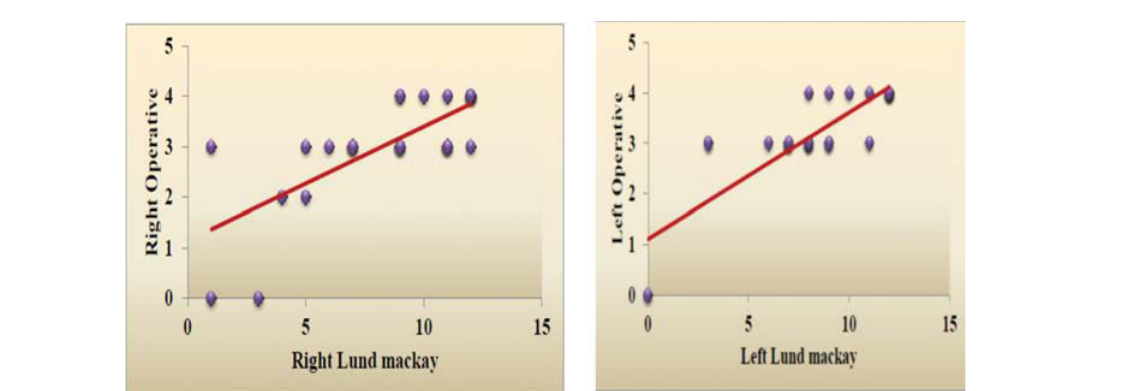
There was a highly significant positive correlation between operative endoscopic and Lund – Mackay staging scores with a P value of less than 0.001, and the ( r ) Spearman correlation coefficient was (right side = 0.731 and left side =